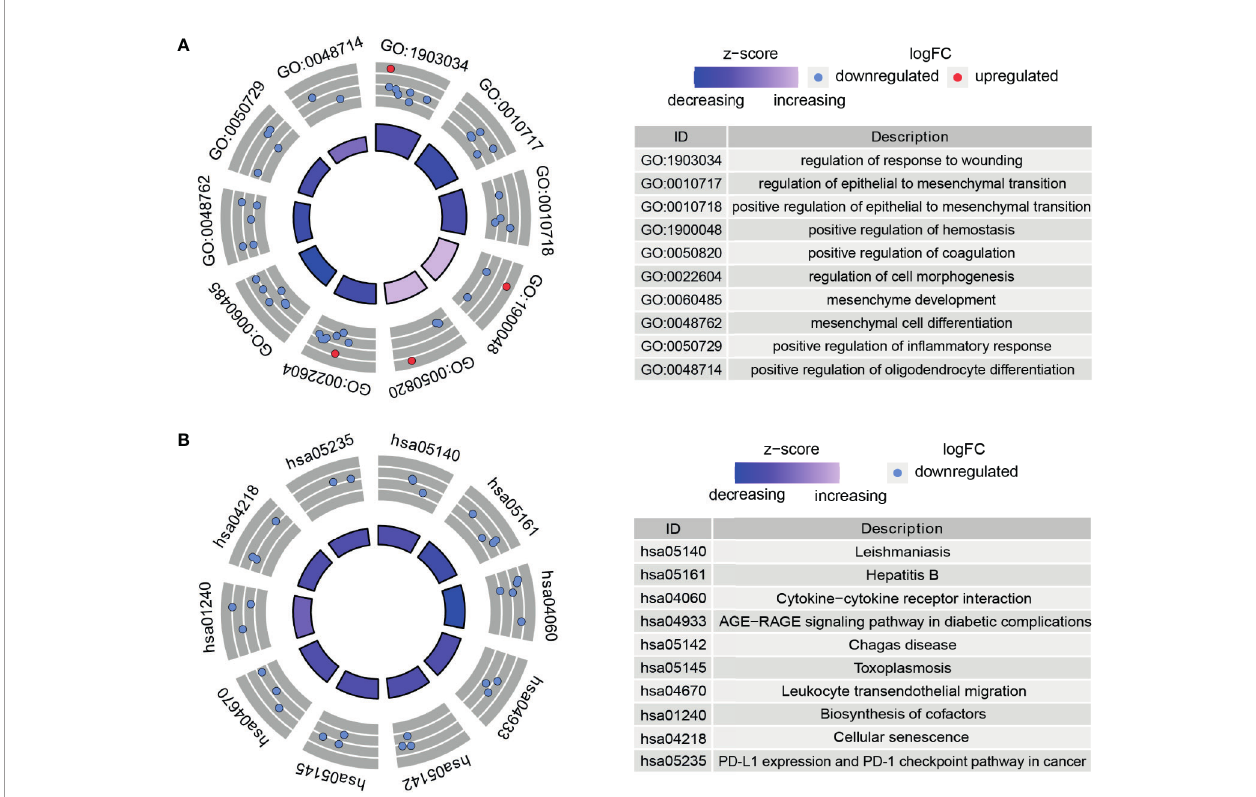
FIGURE 3 | Functional enrichment analysis of DMDGs in GBM. (A) GO enrichment analysis. (B) KEGG pathway enrichment analysis. The color of inner circle represents z scores: red dots indicate high z scores while blue dots indicate low z scores. The band thickness of inner circle represents the signi fi cance of GO terms. The outer circle represents the expression level of DMDGs in each enriched GO term: the dot colors from blue to red denote the trend from hypermethylated to hypomethylated